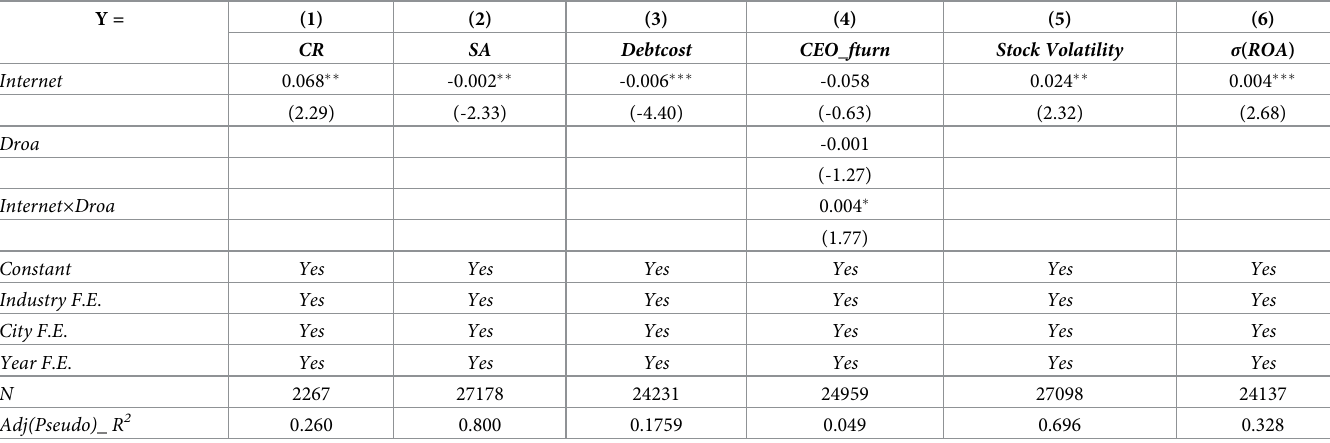
Table 5. Transmission